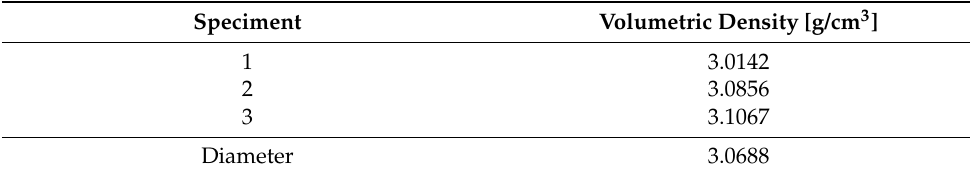
Table 2. Volumetric density of cement CEM II/B-M (S-LL) 32.5 R.